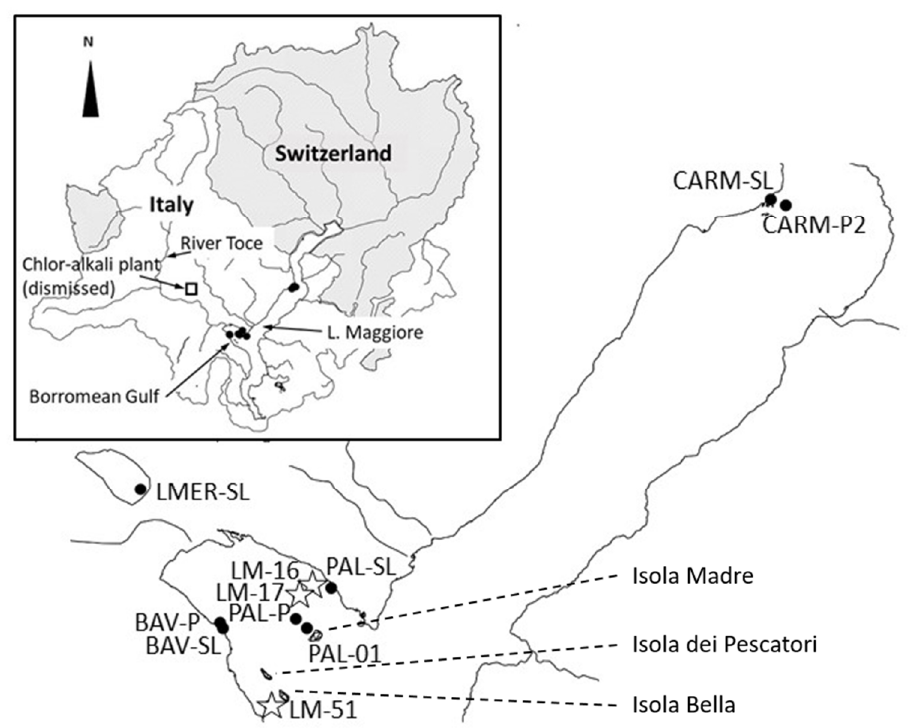
Figure 1. Lake Maggiore watershed (Italy / Switzerland): white box = position of the chlor-alkaly plant; black dots = sampling sites for indigenous chironomids, oligochaetes and bottom sediments; white stars = location of sediment cores collected during previous studies [21,22]. See text for details and Table 1 for site codes.